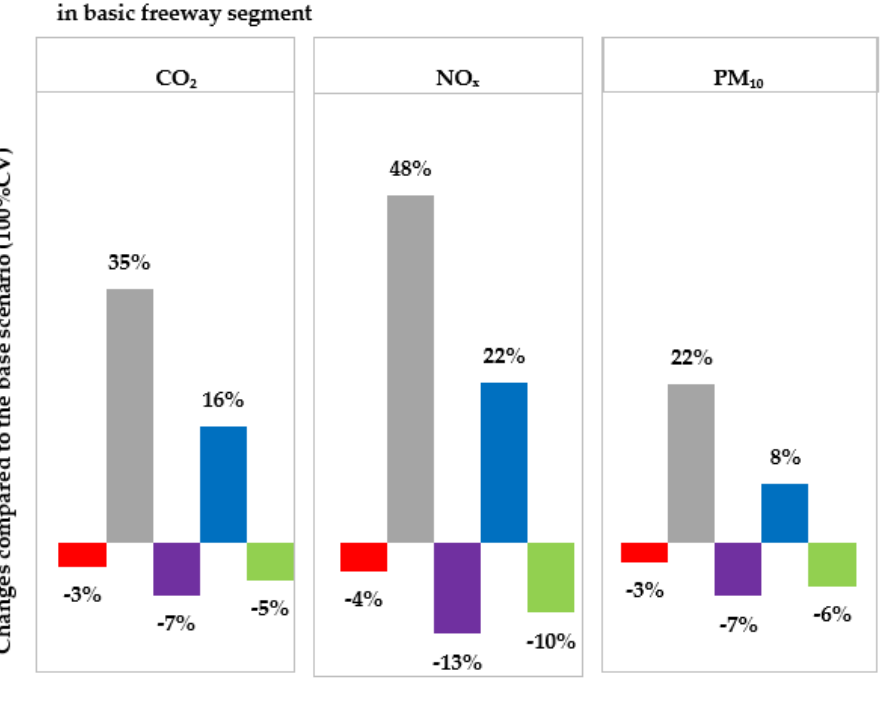
Figure 6. Simulation results of traffic emissions compared to the base scenario (100% CV): basic freeway segment.